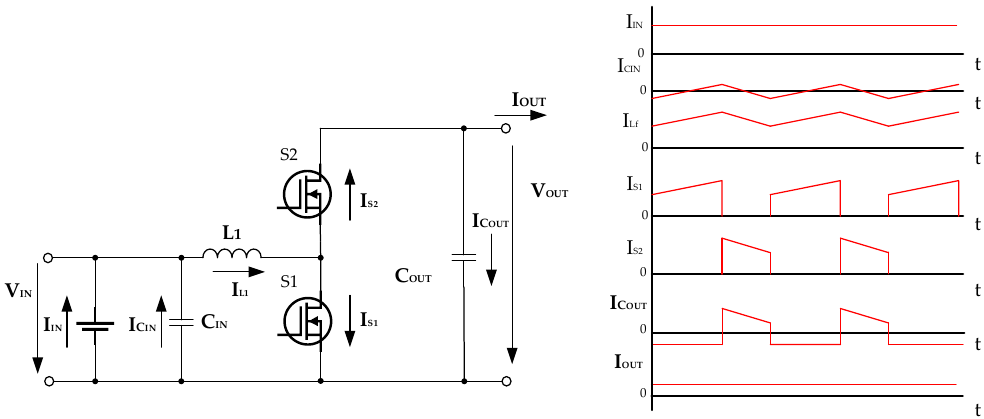
Figure 2. Operational properties of bidirectional buck/boost converter ( left ) and its circuit diagram ( right ).